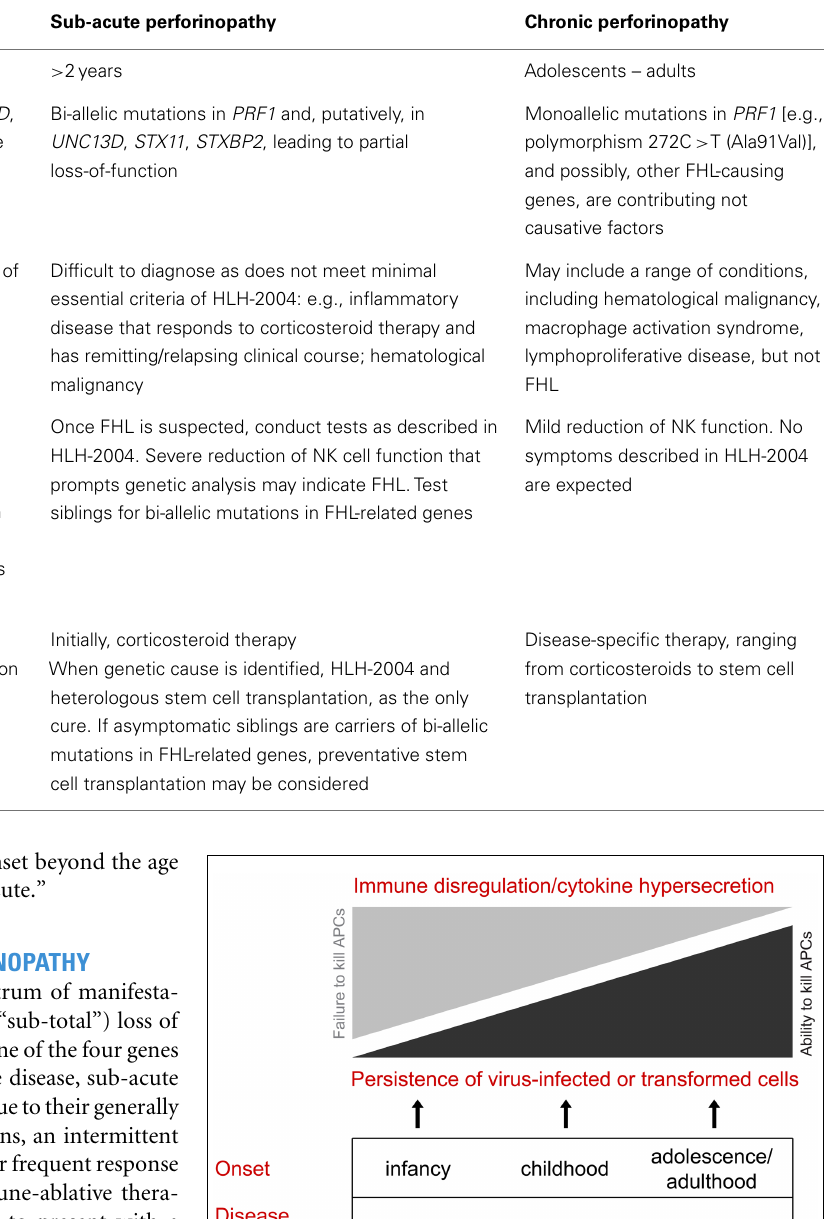
Table 1 | Possible clinical manifestations of perforinopathy .